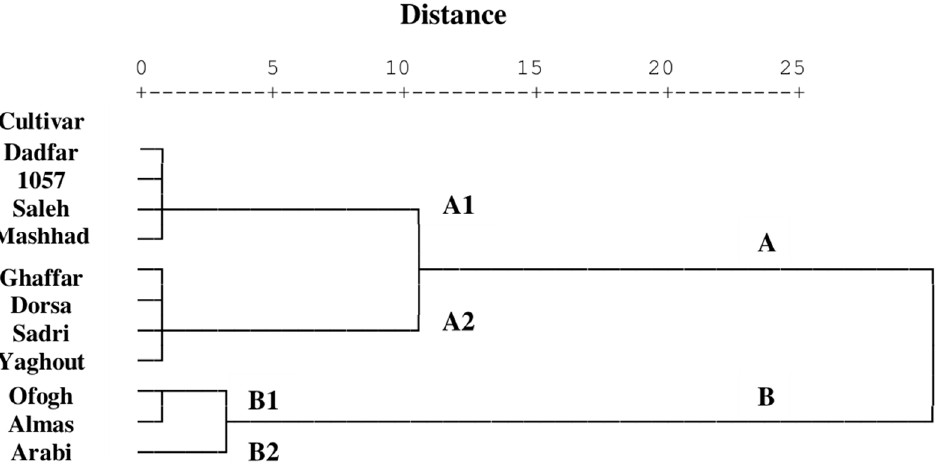
Figure 4. Dendrogram from cluster analysis of various legumes based on life table parameters and digestive proteolytic and amylolytic activities of Spodoptera littoralis in response to feeding on various legumes cultivars (Ward’s method).